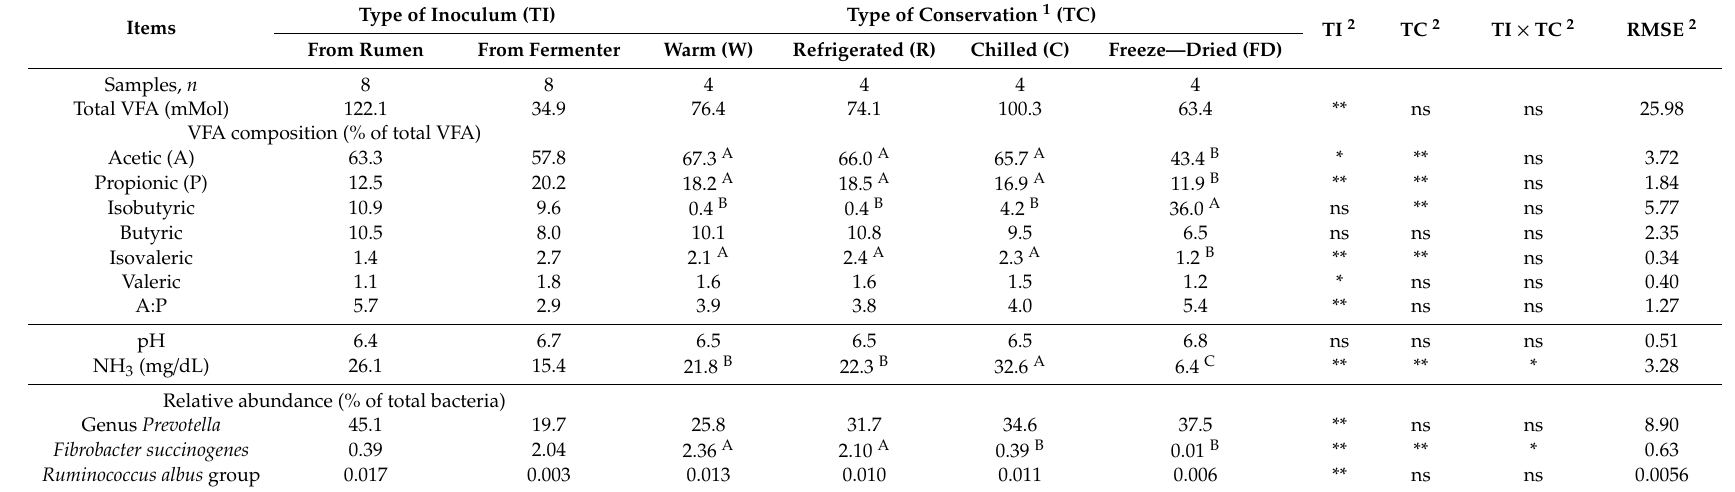
Table 2. Volatile fatty acid (VFA) content, pH, ammonia (NH 3 ) content and bacteria abundance of fermentation liquids from inoculum di ff ering for origin and for